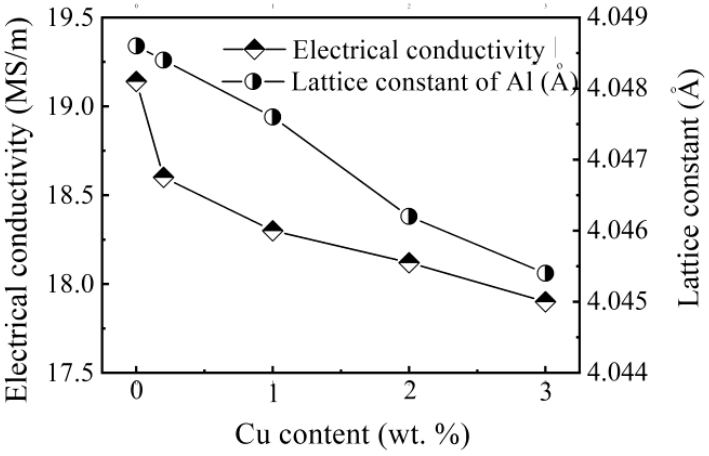
Figure 5. Relationship between Cu content and electrical conductivity, and lattice constants.